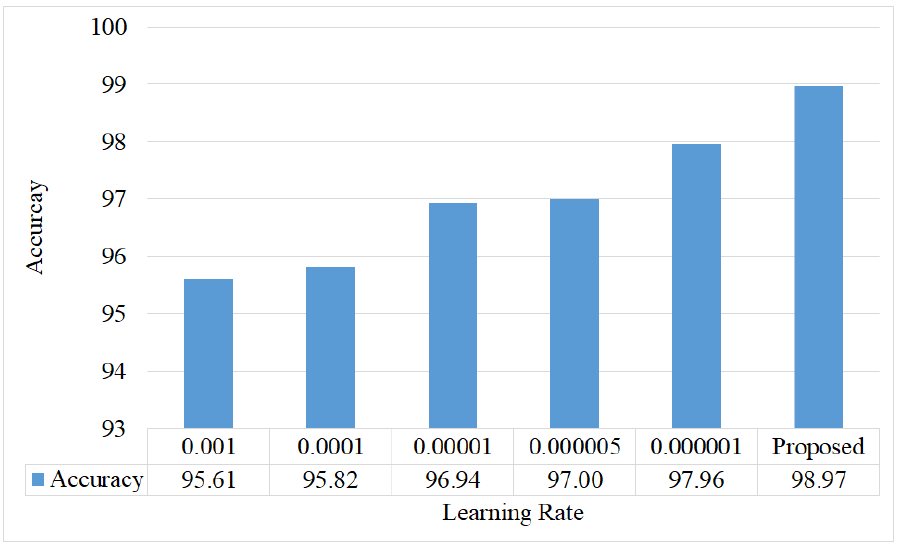
Figure 9. Accuracy vs. learning rate graph for dataset-2.